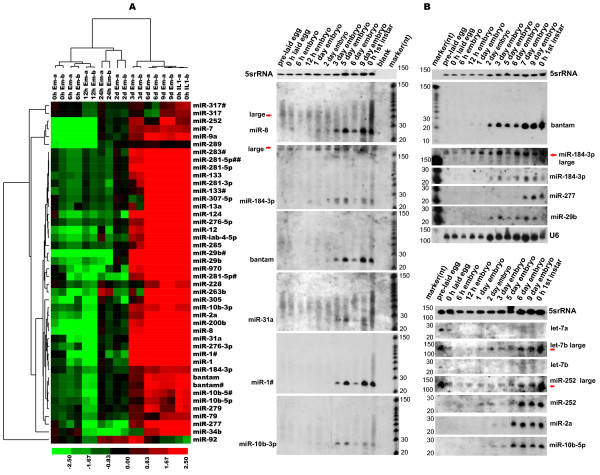
MiRNA expression patterns during silkworm embryonic development. (A) Hierarchical clustering analysis of the expression of 36 miRNAs obtained from embryos of early 1st instar larvae. The colors represent relative and mean-centered expression for each miRNA: green, low; black, mean; red, high. a and b represent the average signals of each probe printed at three points on each block. (B) Northern blotting analysis of miRNAs in the embryos and early 1st instar larvae. 5srRNA and U6 served as the loading controls.